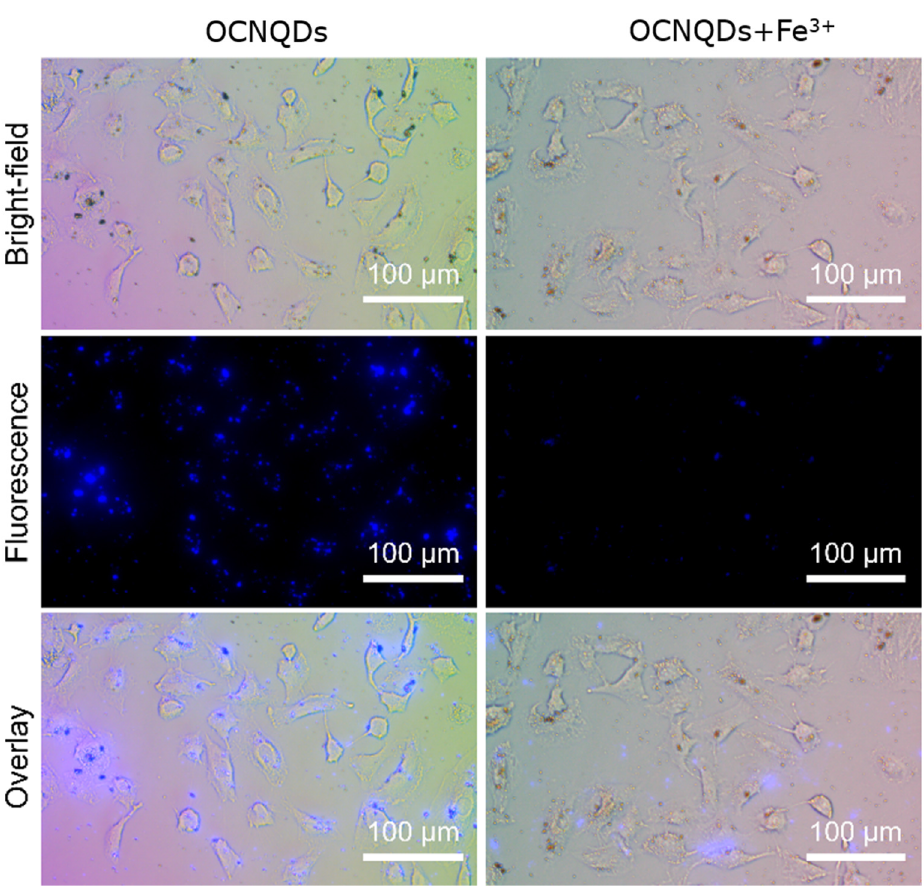
Figure 10. Bright-field, fluorescence, and overlay images of A549 cells incubated with OCNQDs (25 μ g/mL) for 4 h at 37°.